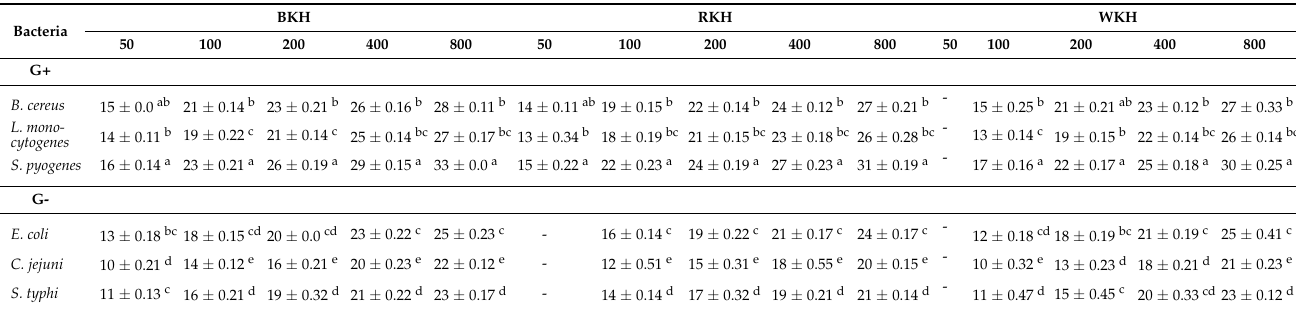
All values are expresses as means ± SD. Means with different lowercase letters in the same column indicate significant differences at p ≤ 0.05 by